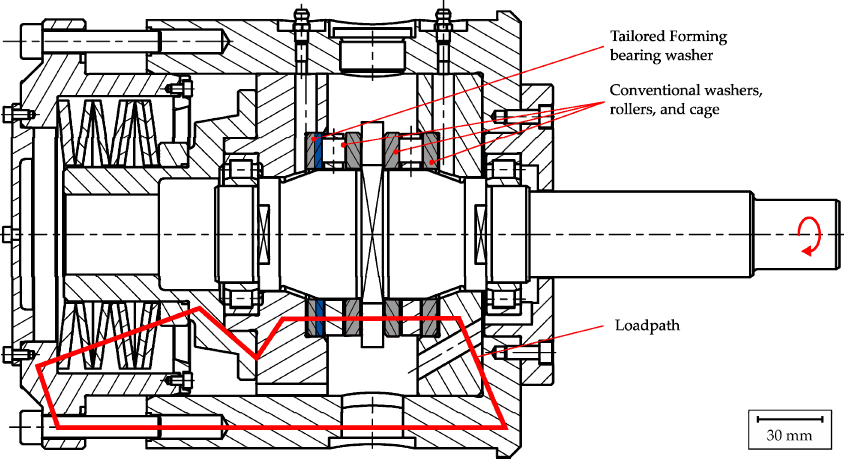
Figure 7. FE8 test head with type 81212 cylindrical roller thrust bearing.